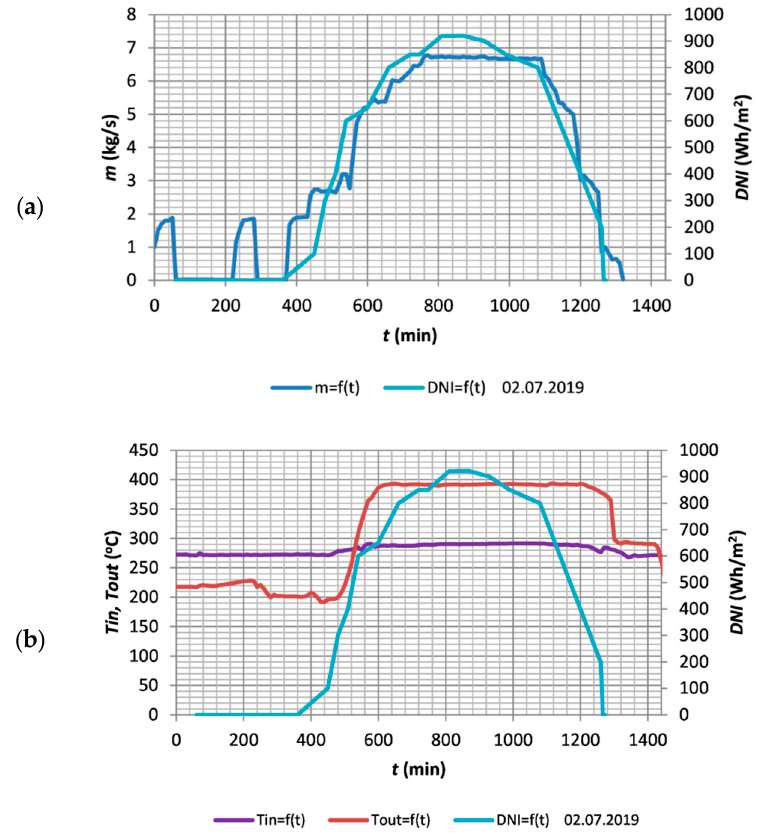
Figure 4. Changes in mass flow m ( a ) and temperature T in and T out ( b ) in a single loop on 02/07/2019 for the Solar Thermal Power Station in Spain.